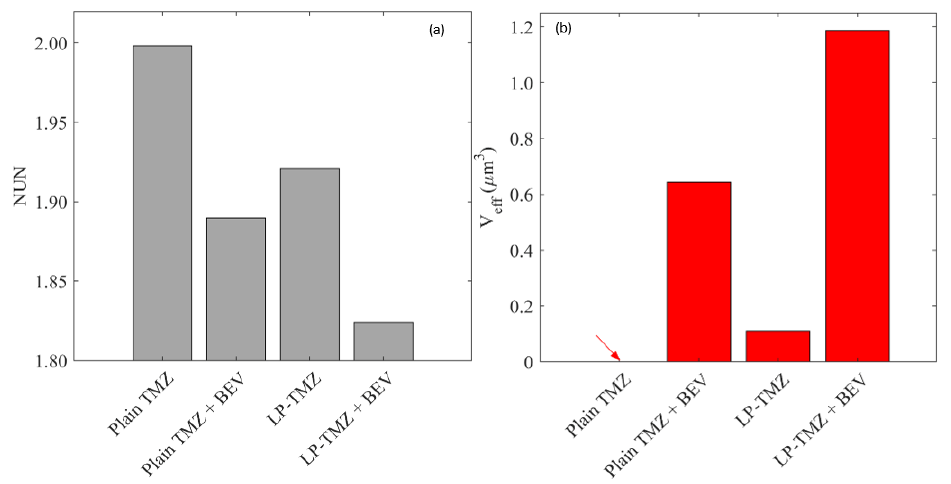
Figure A5. Comparisons of ( a ) drug distribution non-uniformity, and ( b ) effective distribution volume between different regimens in the brain tumor. The results are taken on Day 3.